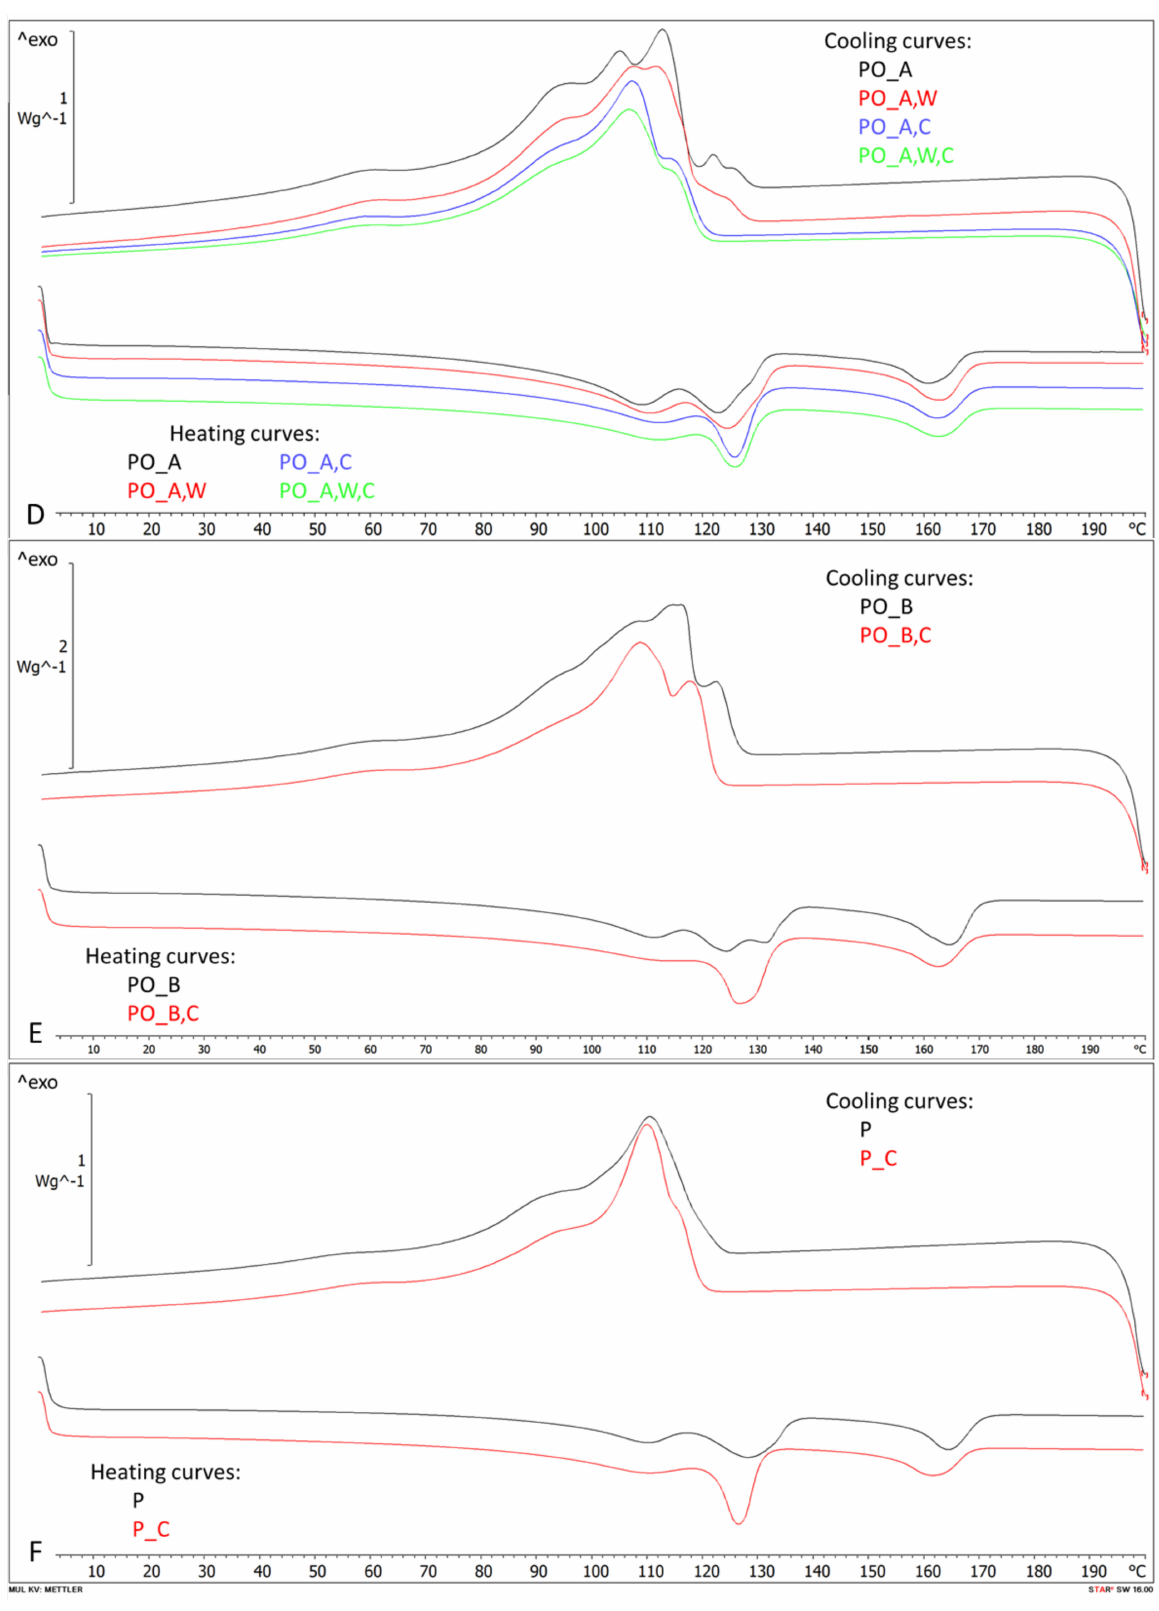
Figure A1. Representative DSC measurement results for ( A ) PE, ( B ) PP, ( C ) PS, ( D ) PO_A, ( E ) PO_B, and ( F ) P materials. Note: cooling with 20 K/min on top and second heating with 10 K/min at the bottom of each